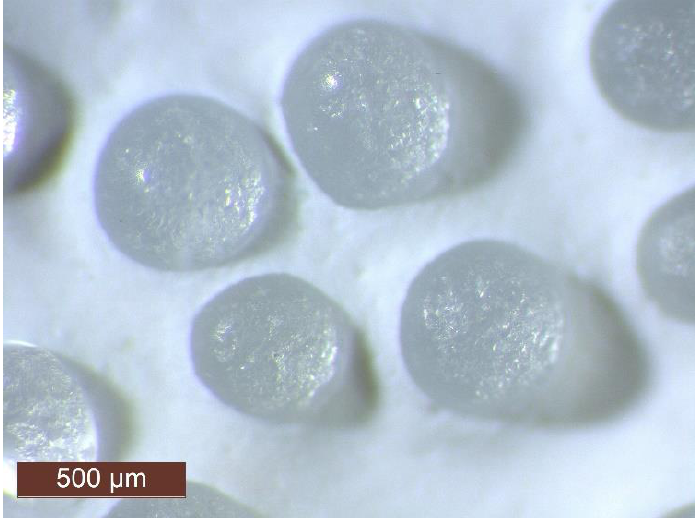
Figure 7. Exemplary severely damaged GB ( high index , sample HI ) after exposure to 6720 drum rotations. Microscope image (magnification 32×).